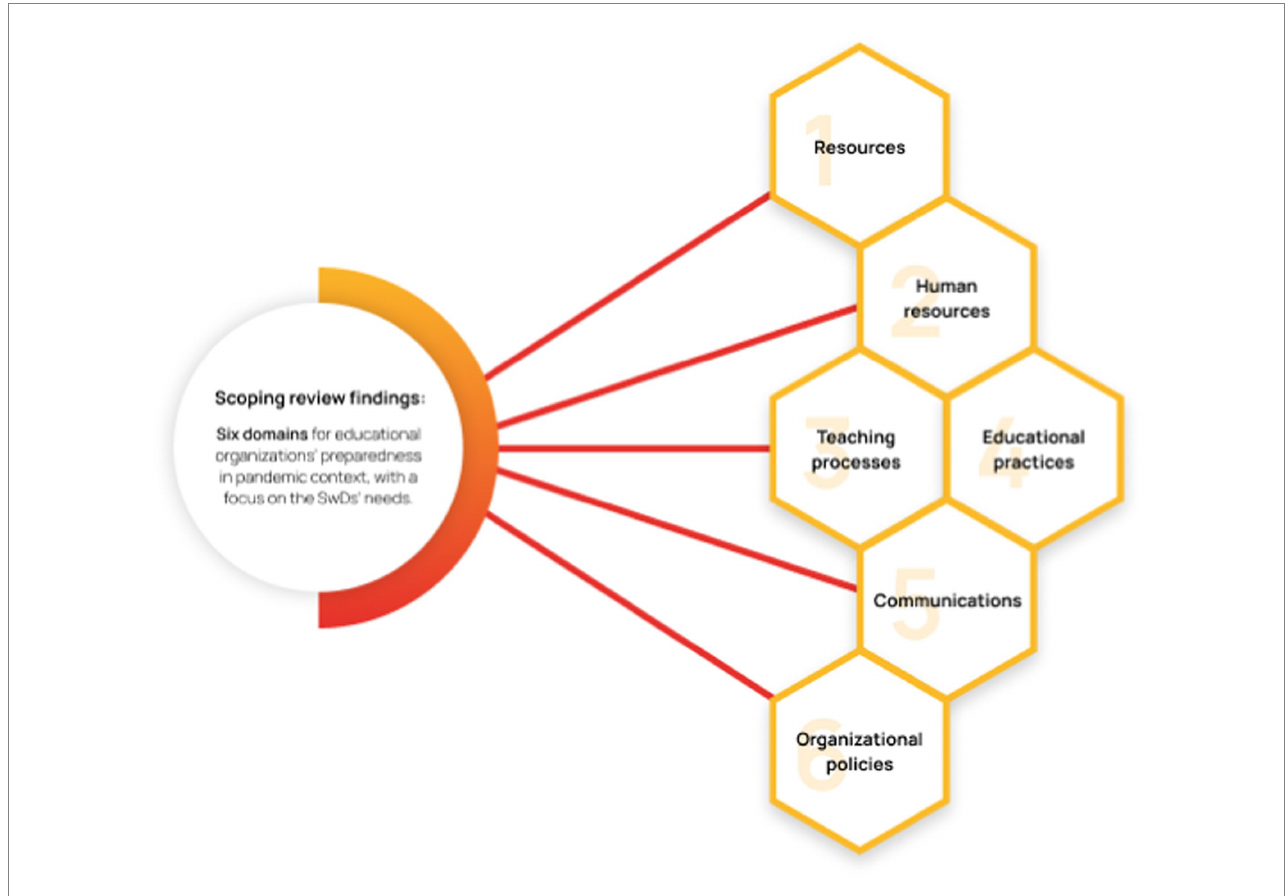
FIGURE 5 System thinking change framework of this